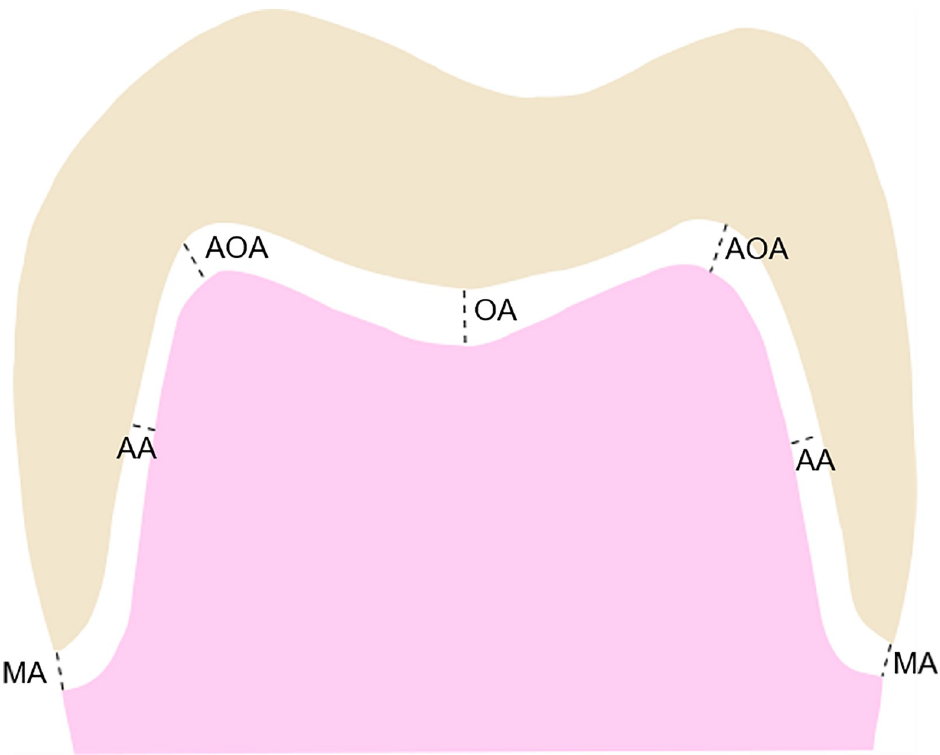
Fig 11. Schematic representation of the measurement points in a cross-section of a specimen. MA: marginal area; AA: axial area; AOA: axio-occlusal angle; OA: occlusal area.